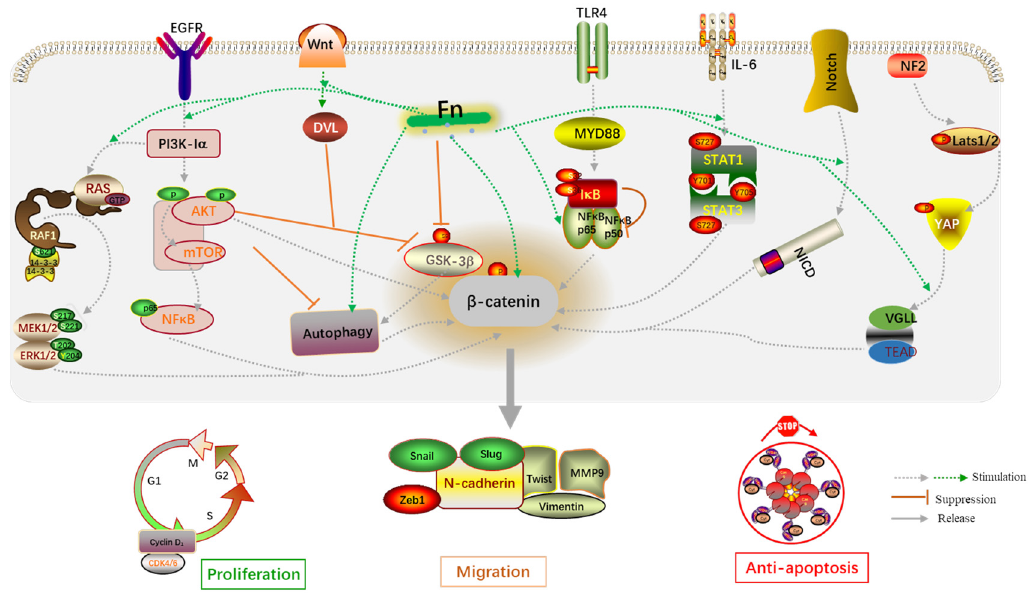
Figure 5. An overview of the molecular mechanisms by which Fn is associated with CRC prolifera- tion and